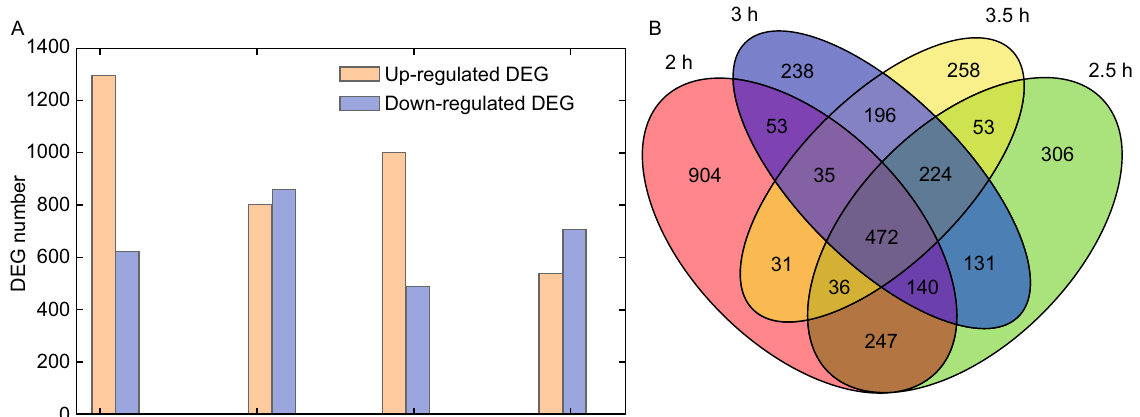
Figure 3. Overview of differentially expressed genes (DEGs). (A) DEG number of CYC2 KO strains and wild type strains at four time stages (2, 2.5, 3, and 3.5 h after conjugation initiation). (B) Venn diagram identifying transcriptome DEG features between KO strains and wild type strains at four different time stages.